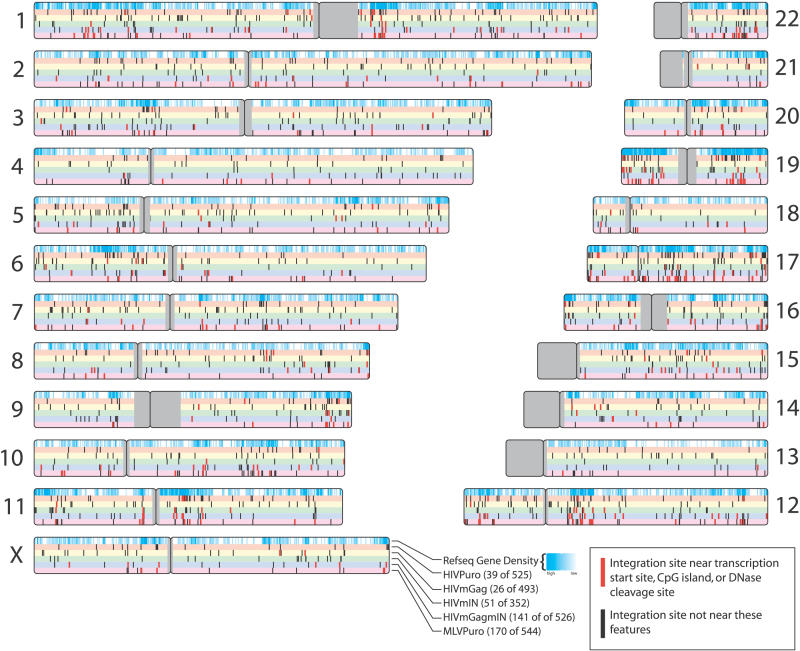
Positions of Retroviral Integration Sites on the Human ChromosomesThe human chromosomes are shown numbered. Centromeric regions (which are mostly unsequenced) are shown in gray. Relative gene density is indicated in the top bar on each chromosome by the intensity of the cyan coloration. Integration-site datasets (lower bars) are color-coded as indicated. Sites of integration near transcription start sites (within ± 5 kb), CpG islands (within ± 1 kb of a CpG midpoint), or 2 DNase I cleavage sites are shown as red dashes; other sites are black.